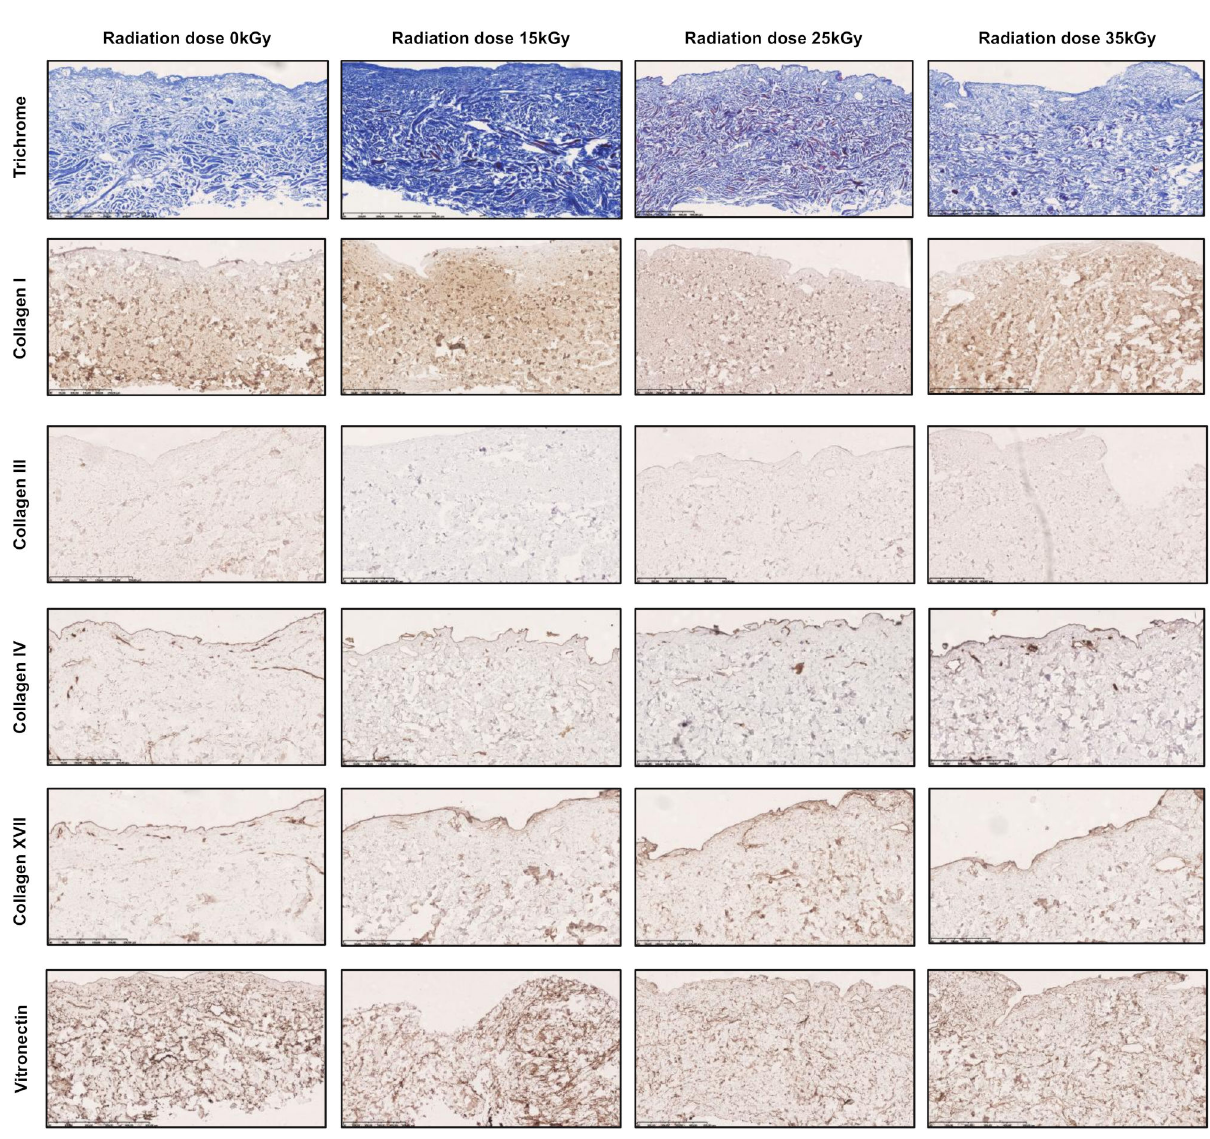
Figure 1. The effect of different doses of radiation sterilization on the collagen structure of decellularized abdominoplastic human dermal matrices. Representative histochemical (trichrome) and immunohistochemical (collagens I, III, IV, XVII, and vitronectin) staining of non-irradiated (0 kGy) and irradiated (15 kGy, 25 kGy, 35 kGy) novel human abdominoplastic skin-derived ADM. Scale bar for trichrome and vitronectin staining 500 µ m; scale bar for collagen staining 250 µ